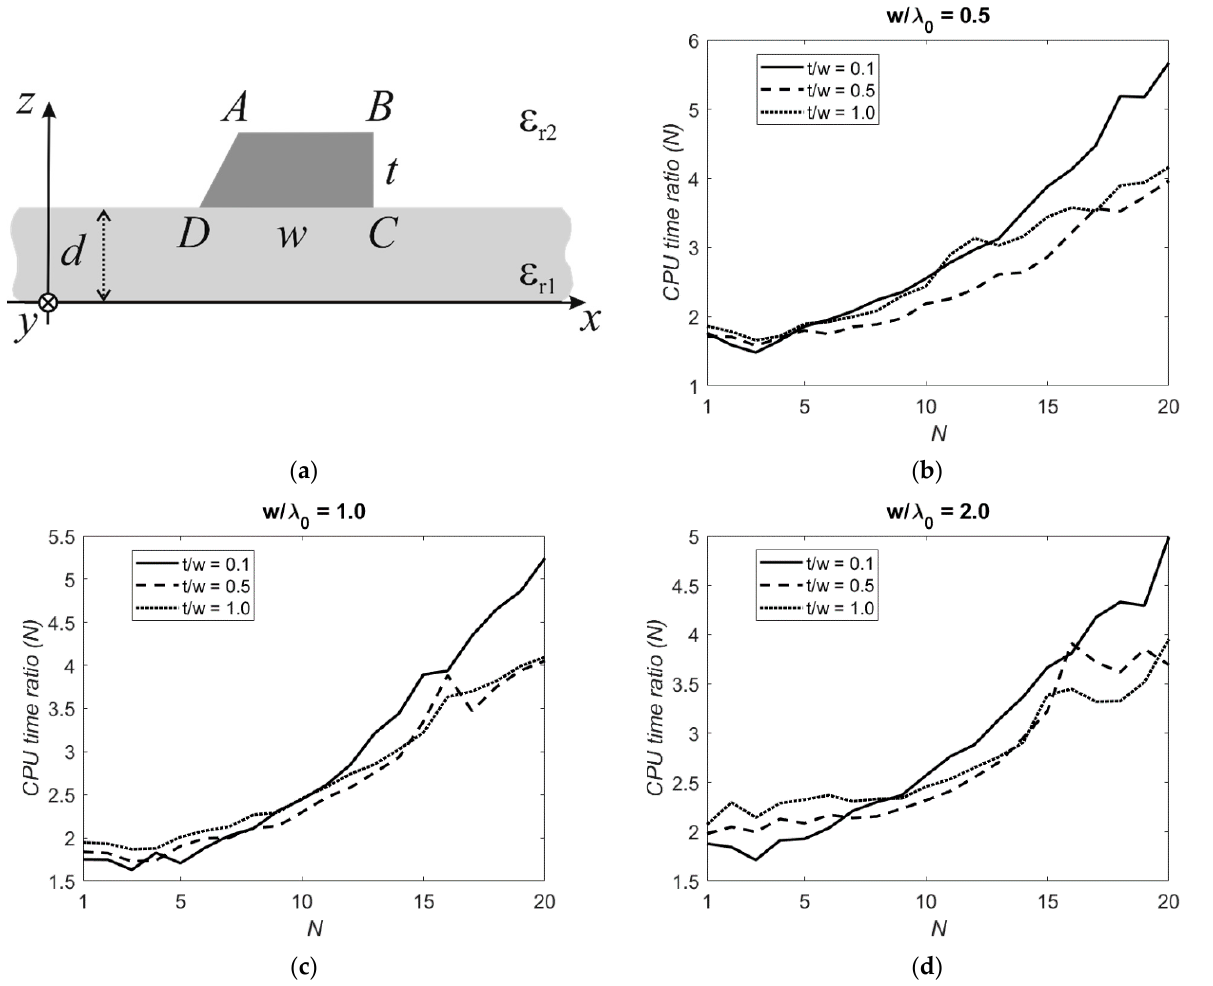
Figure 3. CPU time ratio as a function of the number of expansion functions used for each component of the surface current density on each side of the trapezoidal cross-section strip ( N ) with AB = 3 w /4, BC = t , CD = w , ˆ B = ˆ C = π /2, ε r 2 = 1, ε r 1 = 9.8, d = 0.2117 λ 0 , for v R / k 0 = 1.5, w / λ 0 = 0.5,1.0, 2.0 and t / w = 0.1,0.5, 1.0. ( a ) Geometry of the problem; ( b ) CPU time ration for w / λ 0 = 0.5; ( c ) CPU time ration for w / λ 0 = 1.0; ( d ) CPU time ration for w / λ 0 =